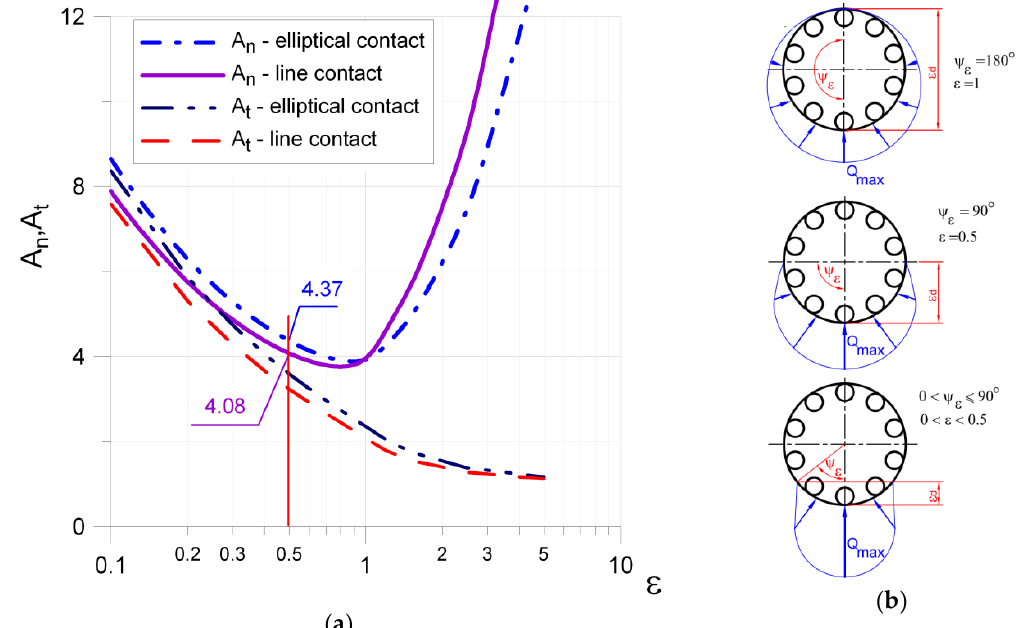
Figure 6. Influence of angle of load distribution ψ ε on A coefficients: ( a ) The values of the coefficients A n and A t of the maximal loading for line and point contact; ( b ) Load distribution on rolling elements in radial bearing angle corresponding to the effectively loaded part.